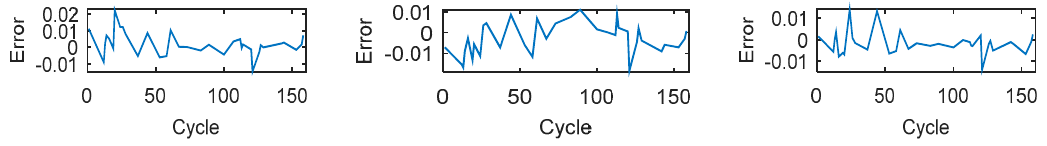
Figure 5. The SOH estimation error of the LS-SVM model with the polynomial kernel tested on the No. 5, No. 6 and the No. 7 batteries. Table 5. Statistical results of the SoH estimation.